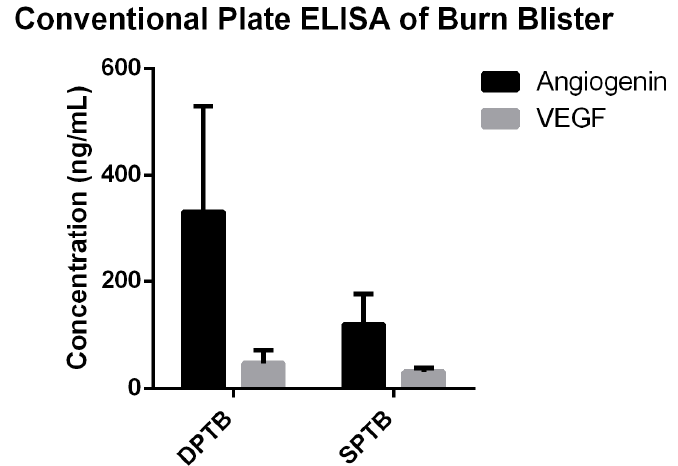
Figure 3. Analysis of angiogenin and VEGF (Vascular endothelial growth factor) concentrations in SPTB and DPTB blister fluids with conventional plate ELISA. A trend toward higher angiogenin concentration in DPTB fluids was detected, compared to SPTB ( n = 4 in SPTB, n = 6 in DPTB, mean ± S.D.; p = 0.07). No significant difference in VEGF levels was observed between two different blister fluids ( n = 4 in SPTB, n = 5 in DPTB, mean ± S.D.; p = 0.26).